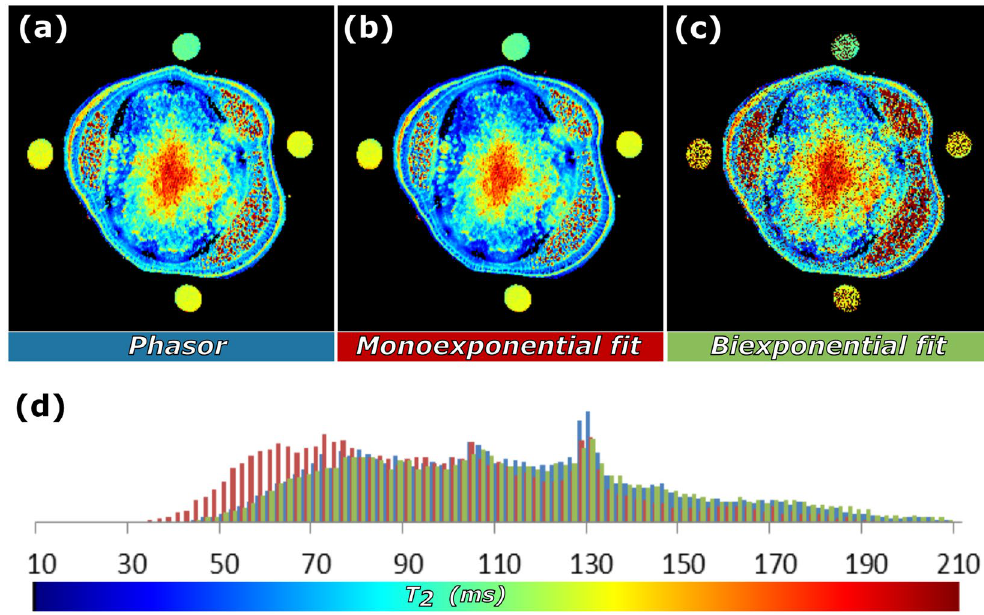
Figure 2. Comparison of quantification by phasor analysis and the Levenberg-Marquardt decay fitting algorithm. T 2 maps of a stem of a tomato plant based on ( a ) phasor analysis, ( b ) mono-exponential and ( c ) bi- exponential fitting; ( d ) comparison of the T 2 histograms for the three methods of